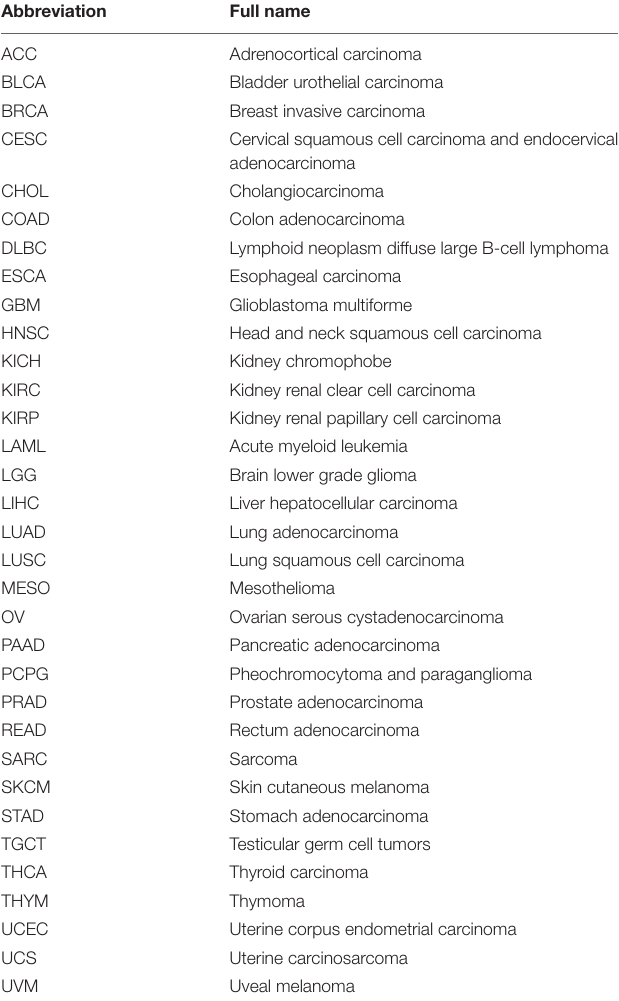
TABLE 1 | Pan-cancer data primary from TCGA